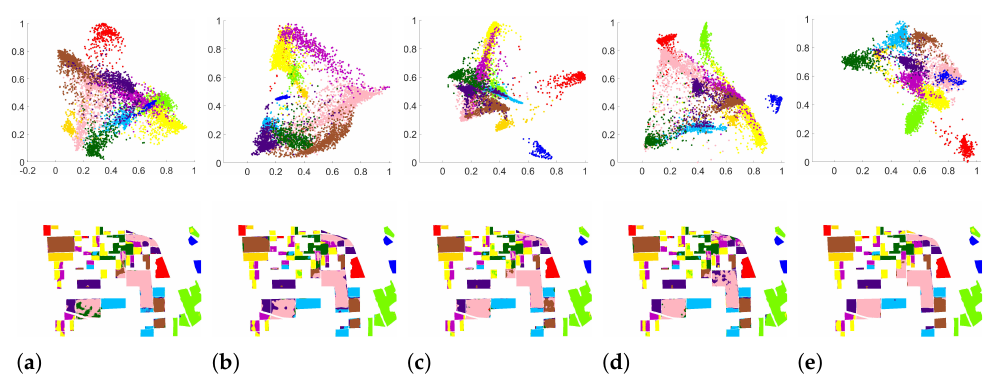
Figure 15. Visualization features of 342-D feature vector and classification results of each loop on AIR-Flev I. ( a ) Origin train. ( b ) Epoch 1. ( c ) Epoch 2. ( d ) Epoch 3. ( e ) Epoch